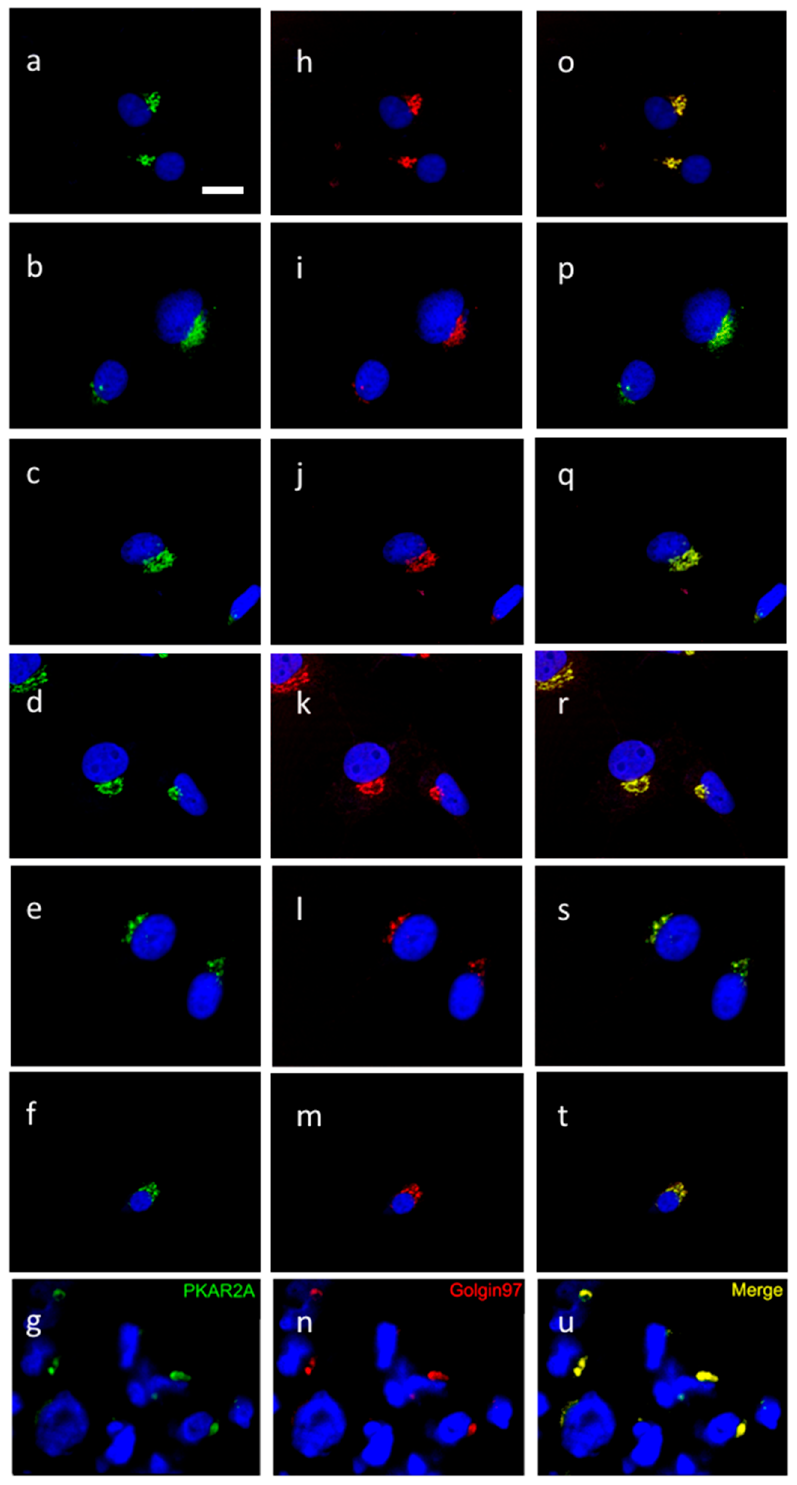
Figure 3. The distribution of PKA R2 in confocal images from: U87 ( a , h , o ), A172 ( b , i , p ), LN229 ( c , j , q ), and GLI36 ( d , k , r ) human cell lines, as well as from two primary cell cultures—from patients 6 ( e , l , s ) and 9 ( f , m , t ), and from GBM tissue (patient 9, g , n , u ). R2 immunoreactivity (green, a – g ) was detected in the perinuclear zone and co-localized with Golgin97 (red, h – n ) as shown by the merging signals ( o – u ); DRAQ5 nuclear staining is shown in blue. Bar = 10 μ m.